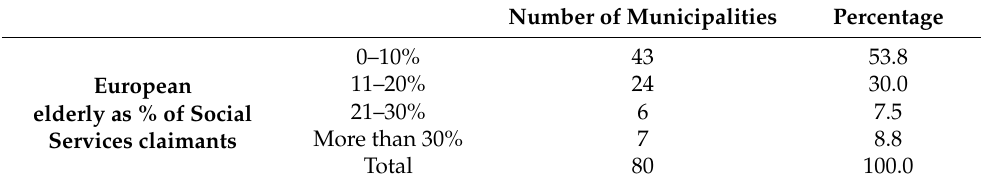
Table 2. Retirement migrants among users of local Social Services.